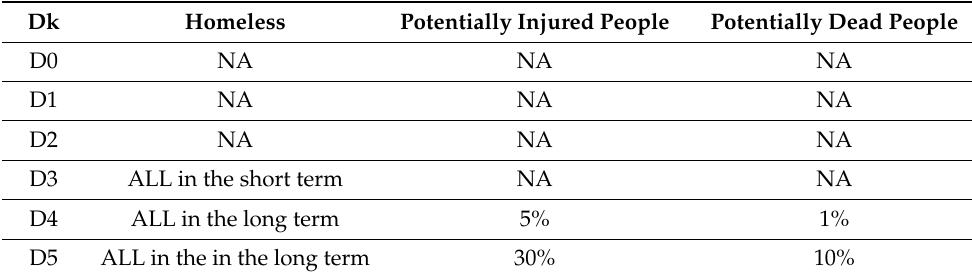
Table 9. Consequences on People estimated based on physical damage levels Dk (k = 0–5). Dk Homeless Potentially Injured People Potentially Dead People D0 NA NA